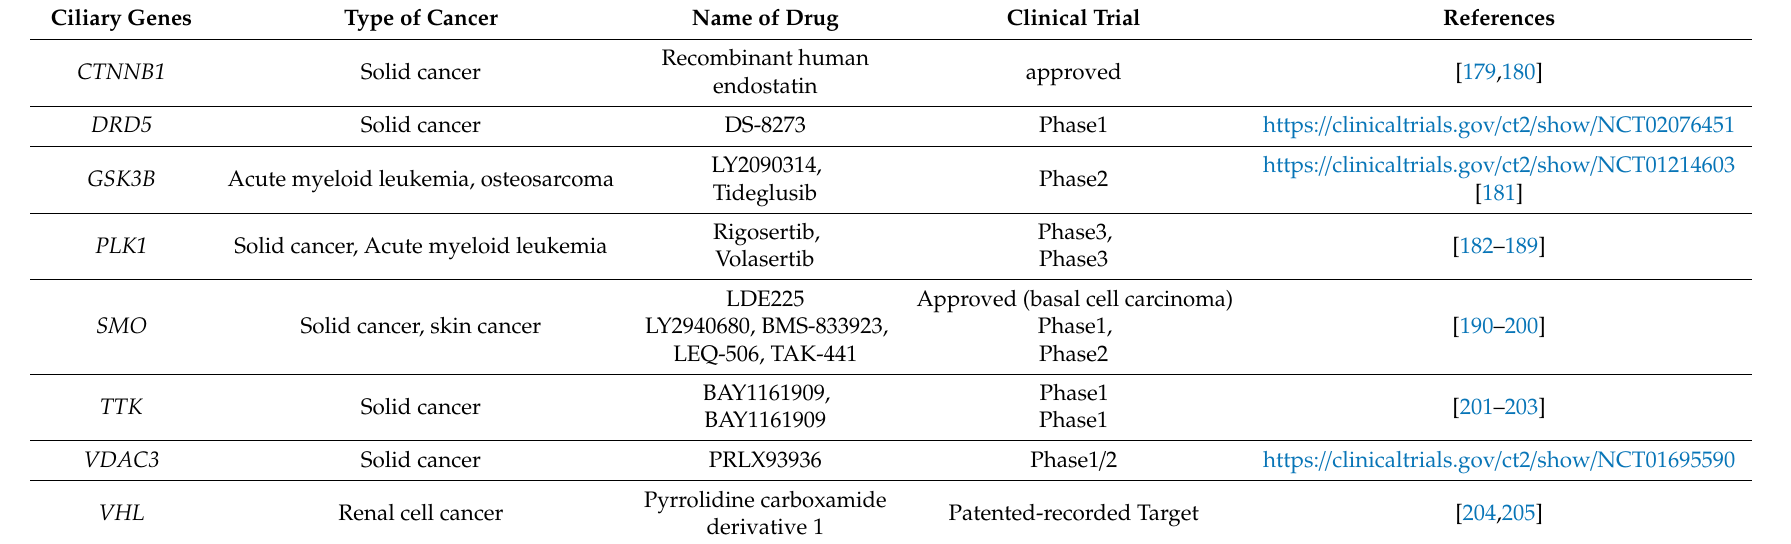
Table 2. Examples of ciliary genes use in cancer clinical trials (from TTD—Therapeutic Target Database http: // db.idrblab.net / ttd / (accessed on 6 November 2019)